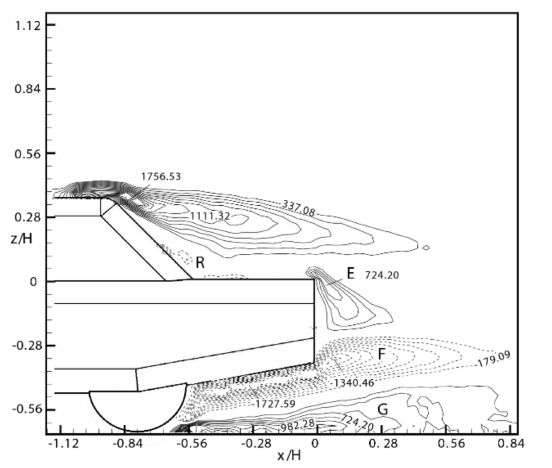
Figure 16. Iso-contours of time-averaged streamwise vorticity ω in x–z plane at y/H = 0. Minimum and incremental values of vorticity are ω y,min = − 179.091 s − 1 , 337.075 s − 1 , and ∆ ω y = 143.379 s − 1 , respectively.